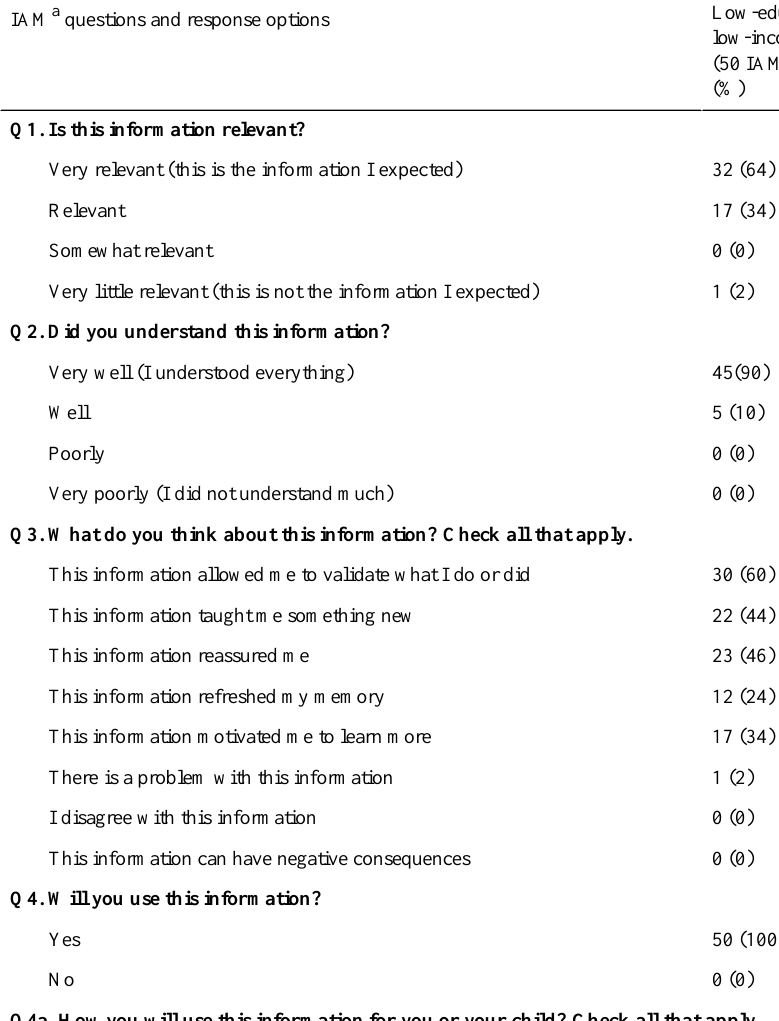
Table 3. Quantitative component—perceived information outcomes: Information Assessment Method ratings of participants with a low level of education and income versus other